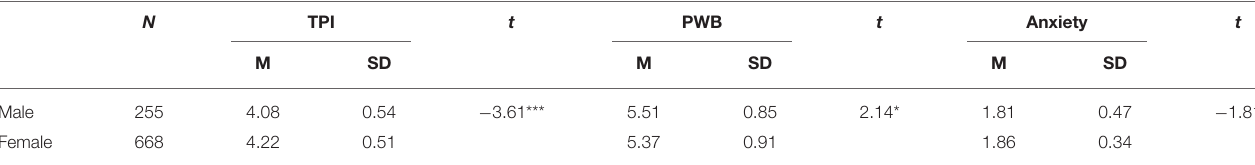
TABLE 5 | Gender differences in means of teacher professional identity, psychological wellbeing and anxiety.